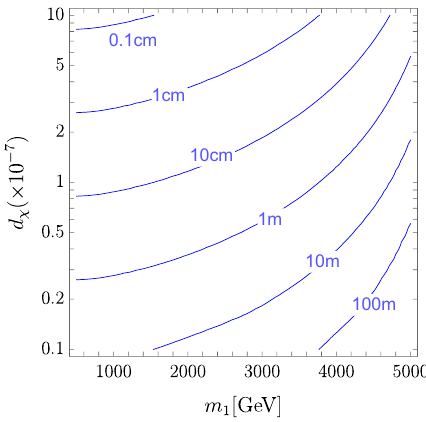
Figure 2 . Decay lengths at rest for the heavy partner (cid:31) 2 in a parameter space where (cid:0) (cid:0) 1 macroscopic (in the cm m range). The mass splitting (cid:1) m is (cid:12)xed, for given m 1 , by the relic (cid:0) density as shown in (cid:12)gure 1. Small values of d (cid:31) and large values of m 1 give origin to larger values of decay